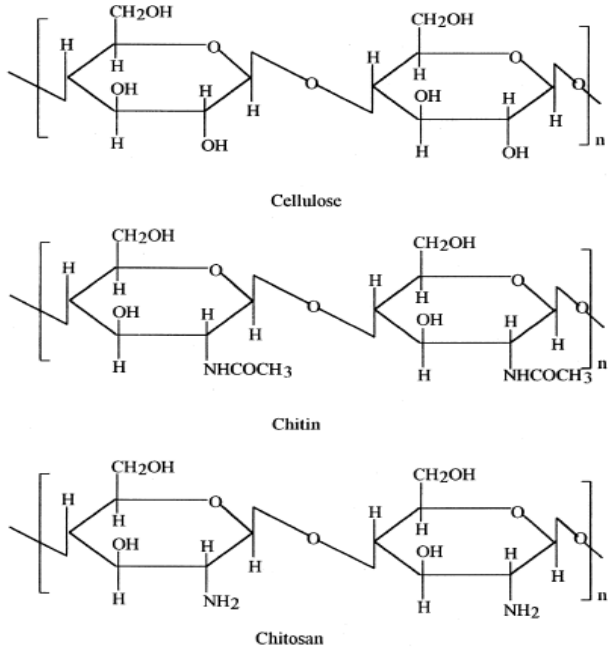
Figure 1. Structures of cellulose, chitin and chitosan. Reproduced from Reference